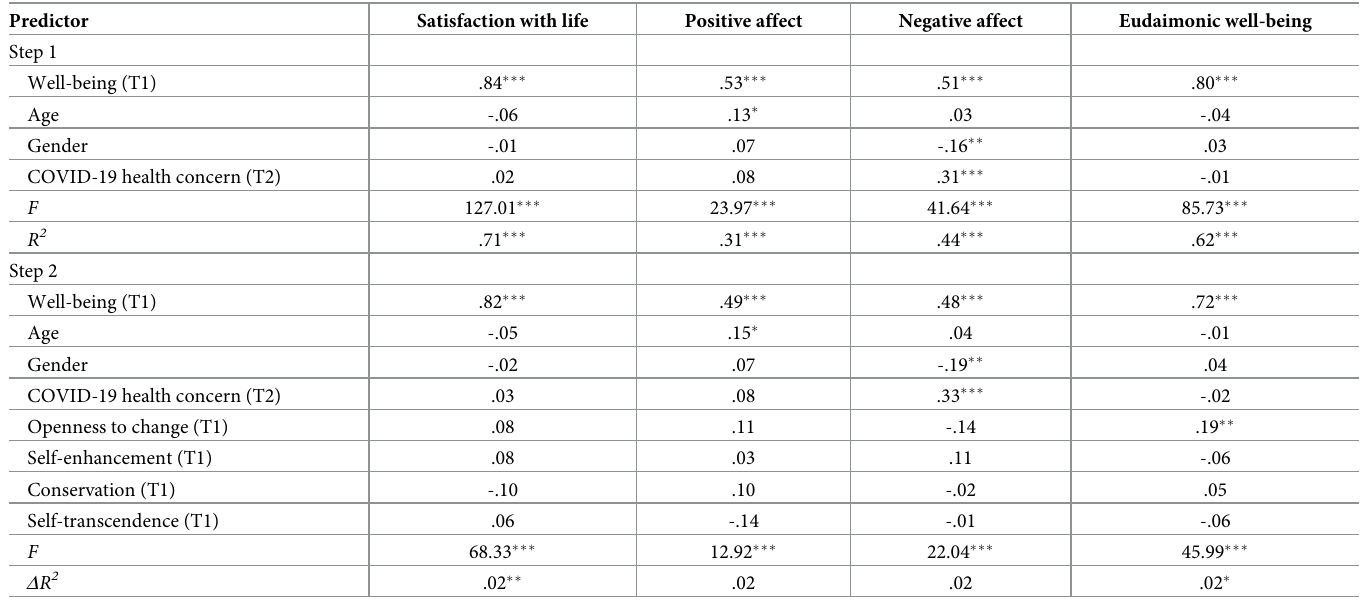
Table 3. Predictors of well-being during the first two weeks of the COVID-19 pandemic